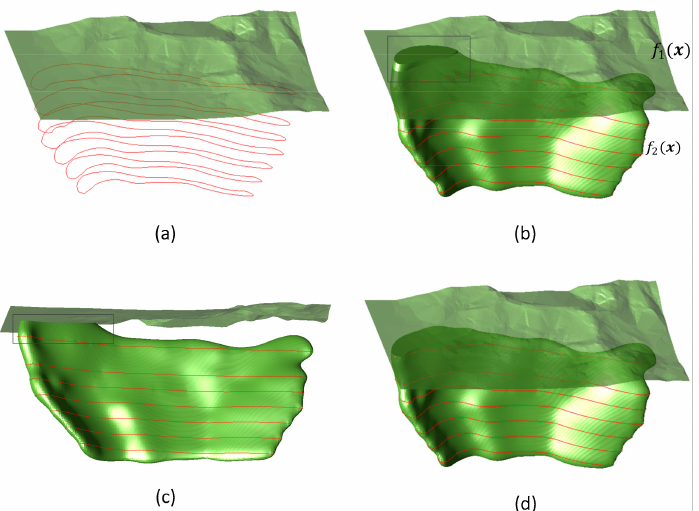
Figure 3. Combination constraint of the topography surface based on the signed distance field: ( a ) the topography surface and interpreted contours; ( b ) the interpolated model without the constraint of topography; ( c ) the interpolated model with a combination constraint; ( d ) the interpolated model with another combination constraint.